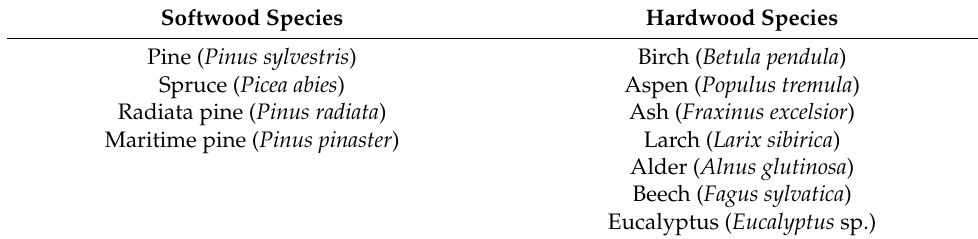
Table 2. Wood species studied for commercial purposes